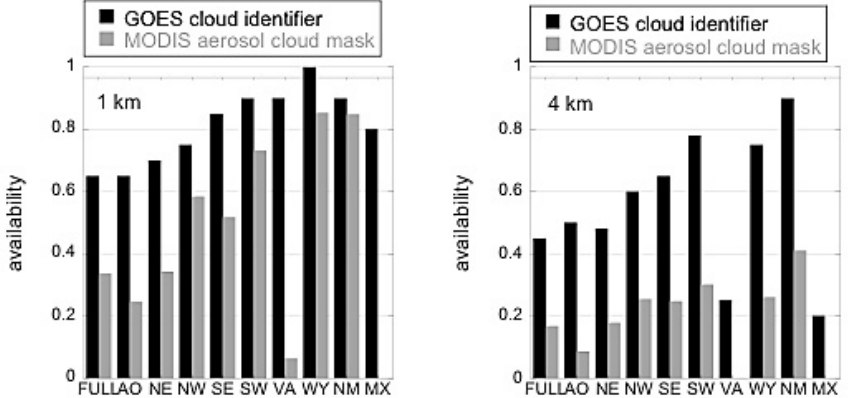
Fig. 12. Aerosol retrieval availability for the full domain and the five subdomains defined in Fig. 5, as well as for the four local 1-degree areas defined in Fig. 9 for one day, 12 August 2010. Shown are the results from using the GOES-R cloud identifier applied to GOES data and the MODIS aerosol cloud mask applied to MODIS data, for 1km resolution (left) and 4km resolution (right). The GOES-R availabilities are calculated for the same time as MODIS overpass and are not diurnal